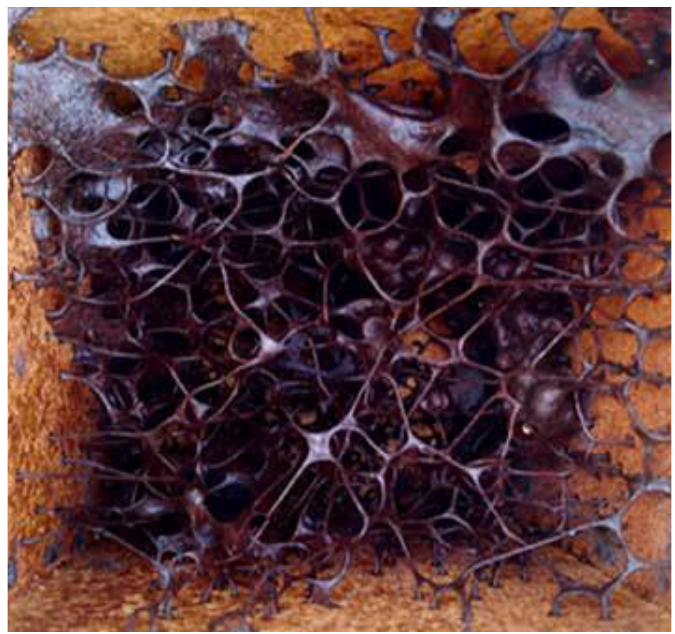
Figure 3. Propolis produced by stingless bees inside a wooden beehive. Adapted with permission from Ref. [81]. 2020, Amalia et al.